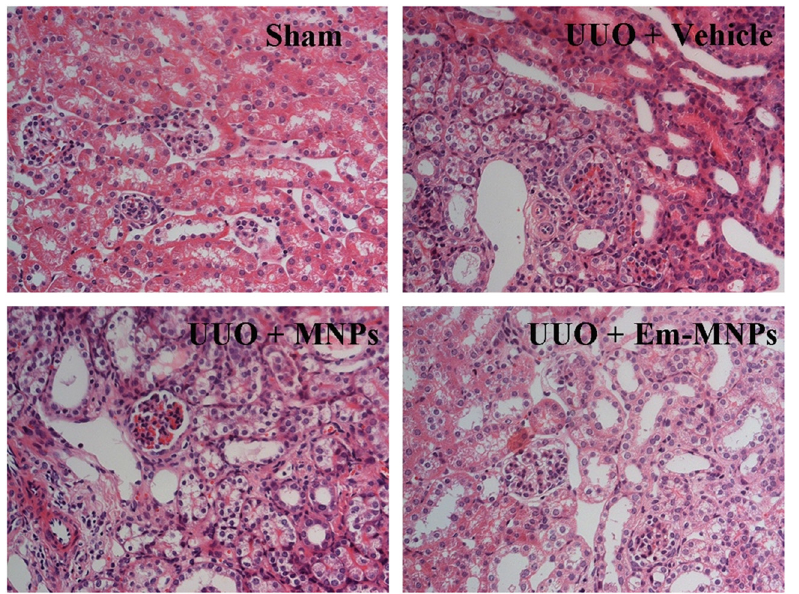
Figure 9: Histology analysis of kidneys. H&E staining images of kidneys from sham - operated, UUO + Vehicle ( PBS ) , UUO + MNPs, and UUO + Em - MNPs